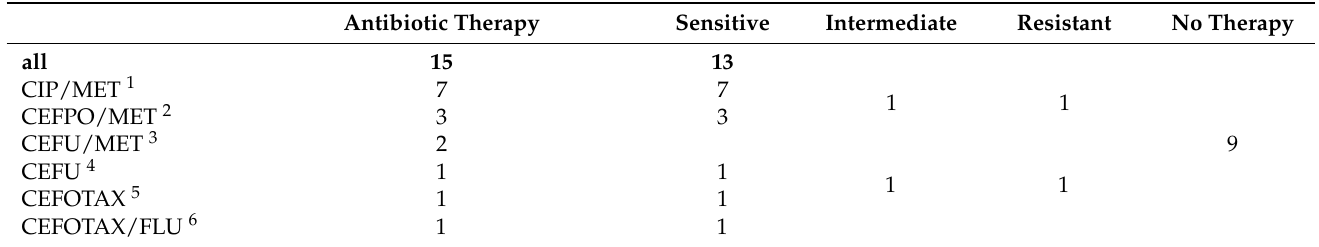
Table 4. Empiric antibiotic therapy and resistance profile for E. coli in patients with